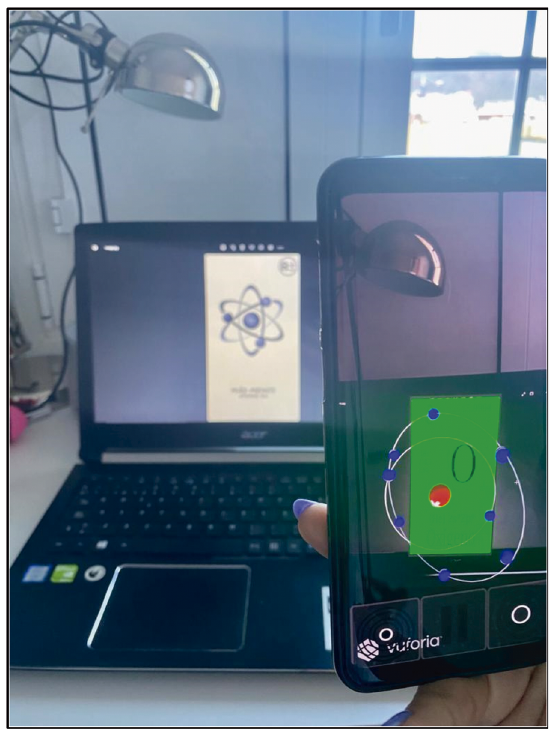
Figure 7. Use of AR Atoms - Oxygen